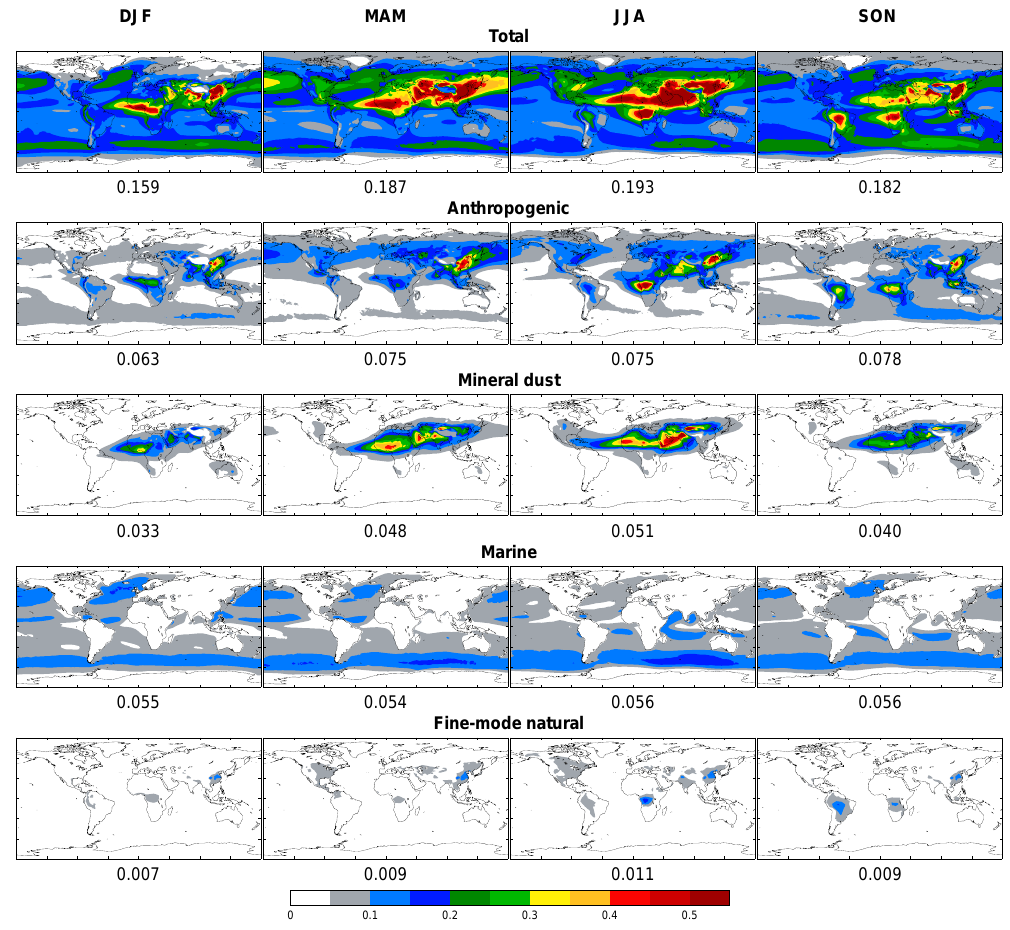
Fig. 2. Seasonal distributions of aerosol optical depth at 0.55µm as derived from the MACC re-analysis over 2003–2010. From top to bottom, the optical depth is for total, anthropogenic, mineral dust, marine, and fine-mode natural aerosols. Global averages are given by the numbers below each